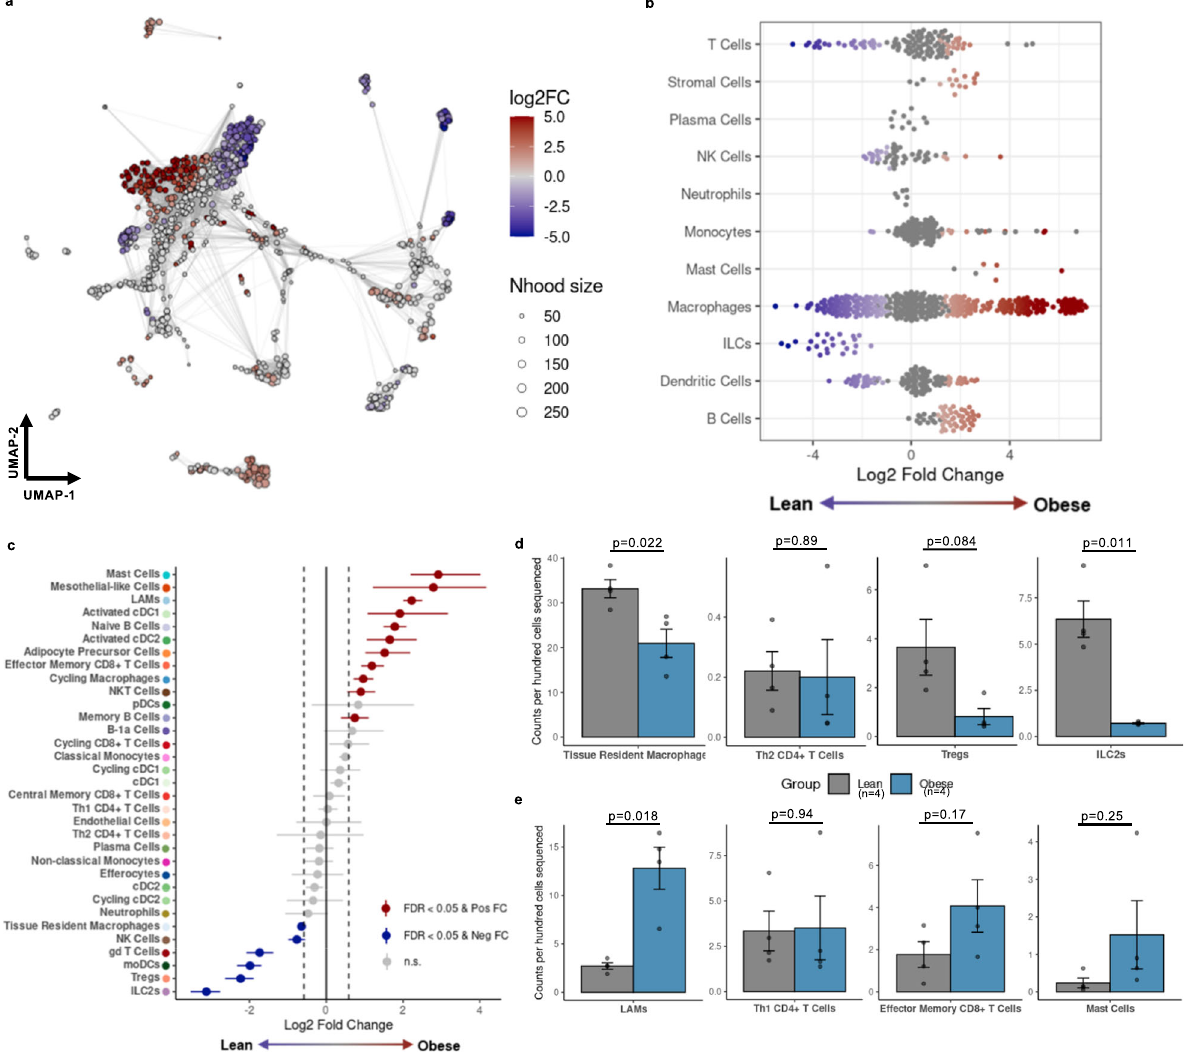
Fig. 3 CITE-seq recapitulates obesity-associated immune cell changes in adipose tissue. a Differential abundance by log fold change (FC) of metacells (index cells representing a neighborhood (Nhood) of cells connected by proximity in Uniform Manifold Approximation and Projection; UMAP) comparing cells from obese mice to lean mice. b Differential abundance of annotated cell types comparing cells from obese mice to lean mice. c Permutation testing of high-resolution clusters to calculate the proportional difference comparing cells from obese mice to lean mice by false discovery rate (FDR). Populations include lipid-associated macrophages (LAMs), conventional dendritic cells (cDCs), plasmacytoid DCs (pDCs), monocyte-derived DCs (moDCs), T helper (Th) cells, T regulatory cells (Tregs), gamma-delta (gd) T cells, natural killer (NK) cells, and type 2 innate-like lymphoid cells (ILCs). d , e Counts per hundred cells sequenced for lean-associated immune cell subsets and obesity-associated immune cell subsets in lean and obese mice (mean ± SEM; n = 4 mice; two-tailed t -test with indicated p values). For diet groups, gray = lean, blue =